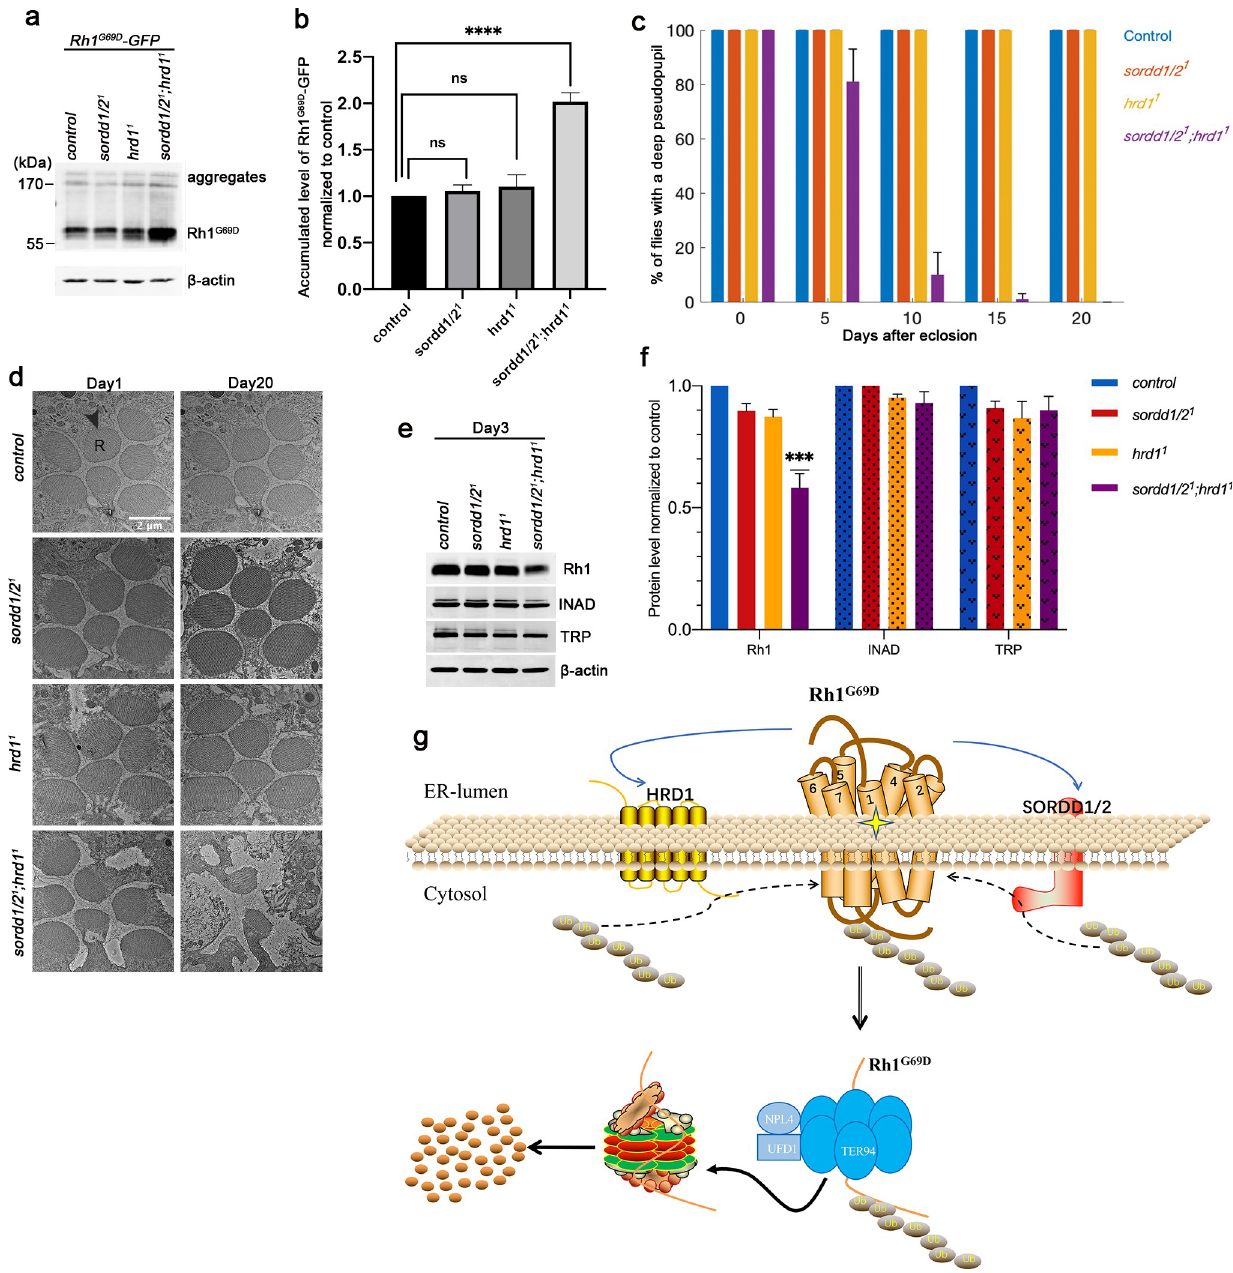
Fig 4. SORDD1/2 and Hrd1 function redundantly in promoting Rh1 G69D degradation. (a) Western blot shows Rh1 G69D -GFP accumulation in sordd1/ 2 1 ; hrd1 1 double mutants ( ey-flp sordd1/2 1 ;FRT82B ninaE-Rh1 G69D -GFP hrd1 1 /FRT82B GMR-hid CL ), compared to sordd1/2 1 ( sordd1/2 1 ;ninaE-Rh1 G69D - GFP ) and hrd1 1 ( ey-flp;FRT82B ninaE-Rh1 G69D -GFP hrd1 1 /FRT82B GMR-hid CL ) mutant alone. Rh1 G69D -GFP is driven by an endogenous ninaE promoter. The higher molecular weight of Rh1 G69D aggregates could be seen at the top of the lanes. (b) Quantification of a , error bars indicate SEM; n = 3, ns, not significant, ���� p < 0.0001 (ANOVA, Sidak’s multiple comparisons test). (c) Quantification of the percentage of the deep pseudopupil in control ( ey- flp;FRT82B ), sordd1/2 1 , hrd1 1 ( ey-flp;FRT82B hrd1 1 /FRT82B GMR-hid CL ) and sordd1/2 1 ;hrd1 1 ( ey-flp sordd1/2 1 ;FRT82B hrd1 1 /FRT82B GMR-hid CL ) flies at 0, 5, 10, 15 and 20 days old. At least ~100 flies in 3 groups were measured for each genotype. Error bars indicate SEM. (d) TEM images of 1-day-old and 20-day-old adult eye tangential sections. Genotypes are as indicated on the left side of the panels. R, rhabdomere. Scale bar, 2 μ m. The sordd1/2 1 ;hrd1 1 double mutant flies show severe degeneration of photoreceptor cells at age of 20 days. All flies are in white eye background, and raised under 12 h light /12 h dark cycles. (e) Western blot analysis of Rh1, TRP, and INAD in control, sordd1/2 1 , hrd1 1 , and sordd1/2 1 ;hrd1 1 flies at 3 days old. (f) Quantification of relative protein levels of Rh1, TRP, and INAD in e ; error bars indicate SEM (n = 3); ��� p < 0.001 (one-way ANOVA, Sidak’s multiple comparisons test). (g) Proposed model of SORDD1/2 in the degradation of misfolded Rh1 G69D parallel to HRD1 complex.